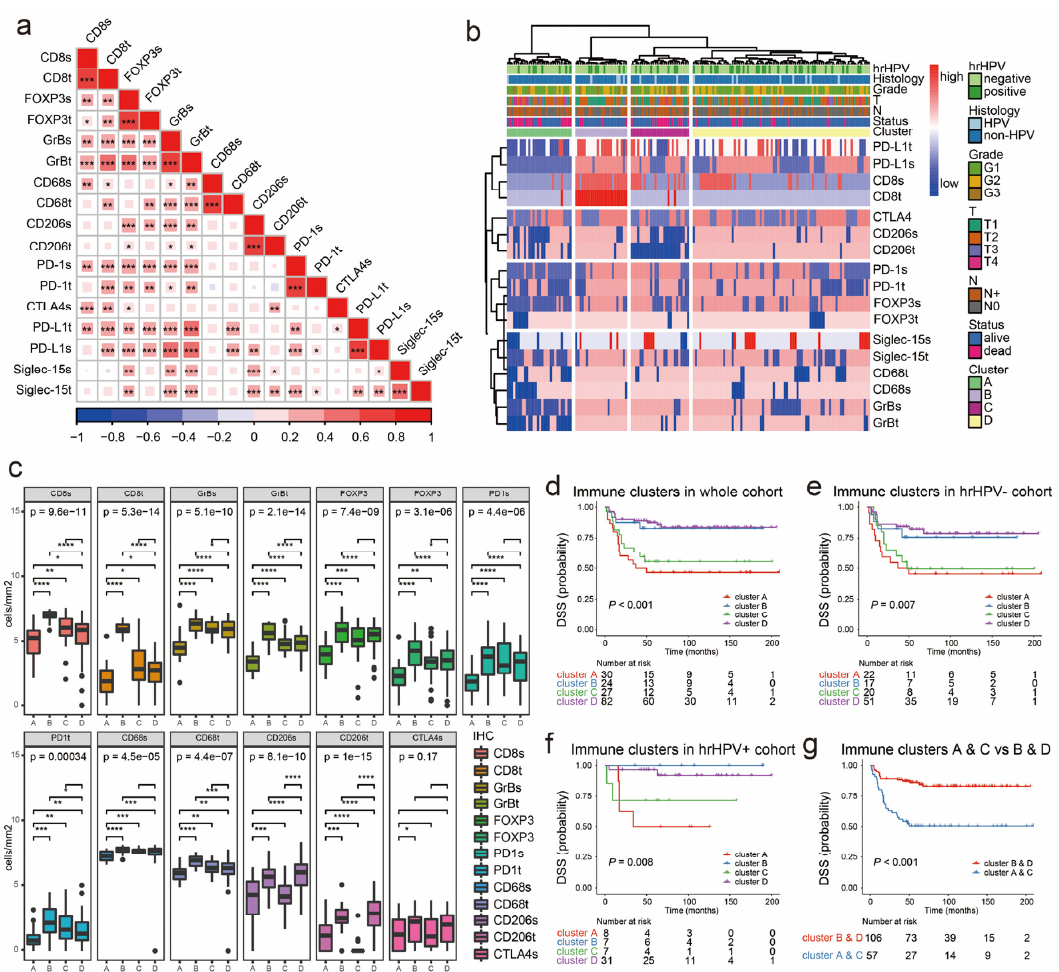
Figure 4. The immunophenotypes of the tumor immune microenvironment (TIME) in peSCC. ( a ) Correlation matrix plots by Spearman correlation analyses show pairwise positively stronger correlation of the expression of tested markers. ∗ P < 0.05, ∗∗ P < 0.01, ∗∗∗ P < 0.001. ( b ) Cluster analyses using correlation distance and ward.D were conducted based on the expression of immune markers. The heatmap shows the high expression (red) or low expression (blue) of each immune marker. Annotations of the samples on the top of the heatmap indicate histopathological features, including hrHPV status, histological subtypes, grade, T stage, N stage, survival status, and the four clusters identified by the cutree method. ( c ) Box plots show the expression of immune markers, according to identified four clusters. The transformed densities of CD8, GrB, FOXP3, PD-1, CD68, CD206, and CTLA-4 in the intratumoral and stromal regions were indicated by box plots. ∗ P < 0.05, ∗∗ P < 0.01, ∗∗∗ P < 0.001, ∗∗∗∗ P < 0.0001, Kruskal-Wallis test. ( d–f ) Kaplan–Meier survival curves for disease-specific survival (DSS) show patients in clusters A and C had better prognosis than clusters B and D in all cases (d), hrHPV - cases (e) and hrHPV + cases(f). ( g ) Patients in high-risk group (clusters A and C) were likely to experience tumor progression, compared with those in low-risk group (clusters B and